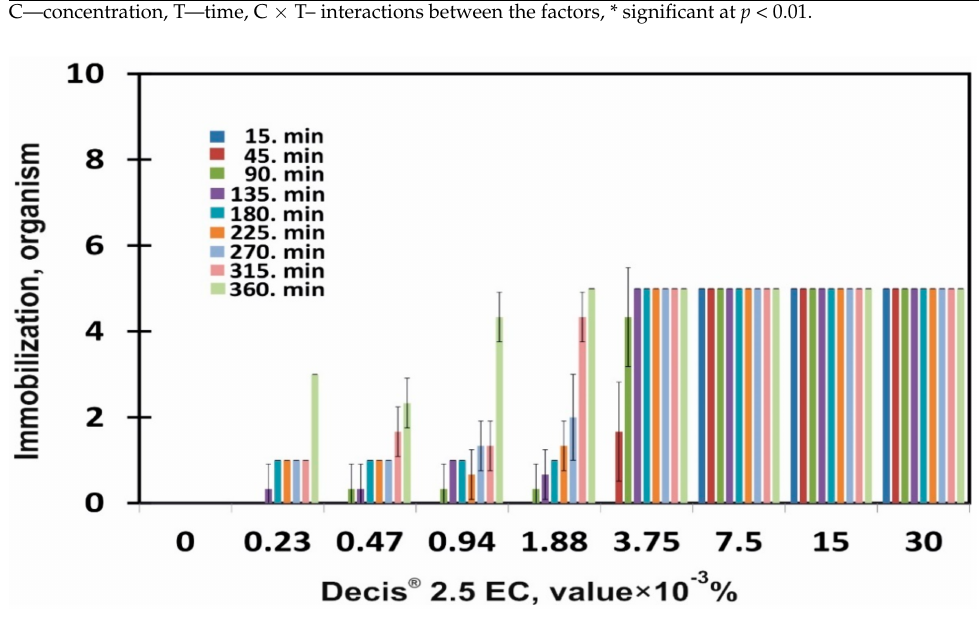
Source of Variation